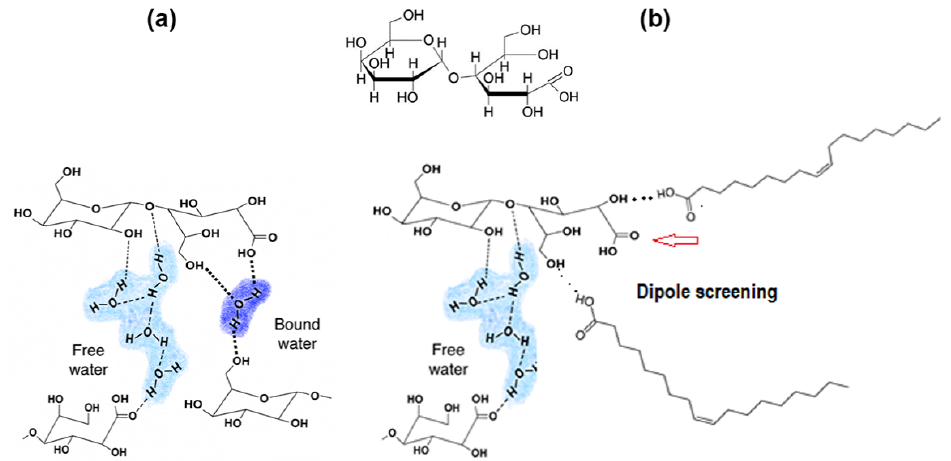
Figure 4. Structure of lactobionic acid [2] and molecular interactions with species in zein-based films; ( a ) weak and strong H-bonds with water; ( b ) weak polar interactions with oleic acid.